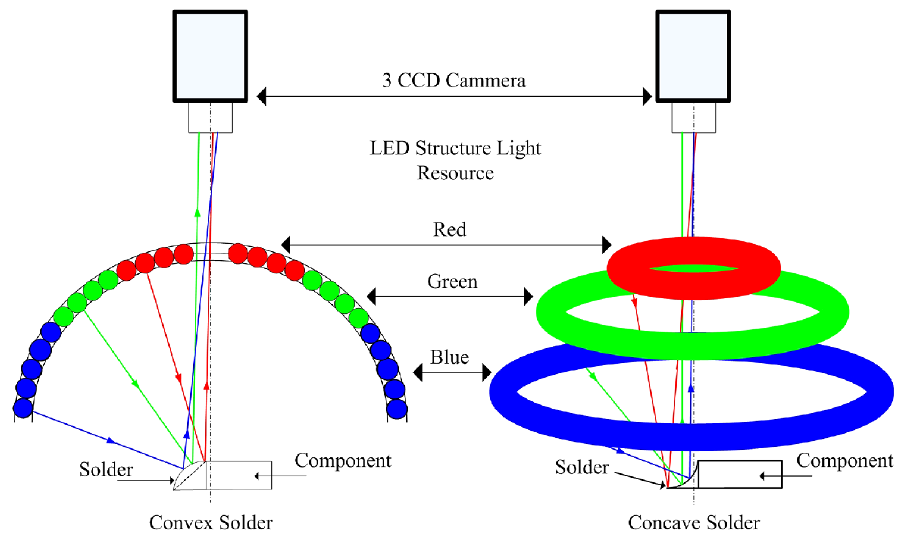
Figure 1. Three Ring LEDs structure taken from Wu and Zhang (2014)